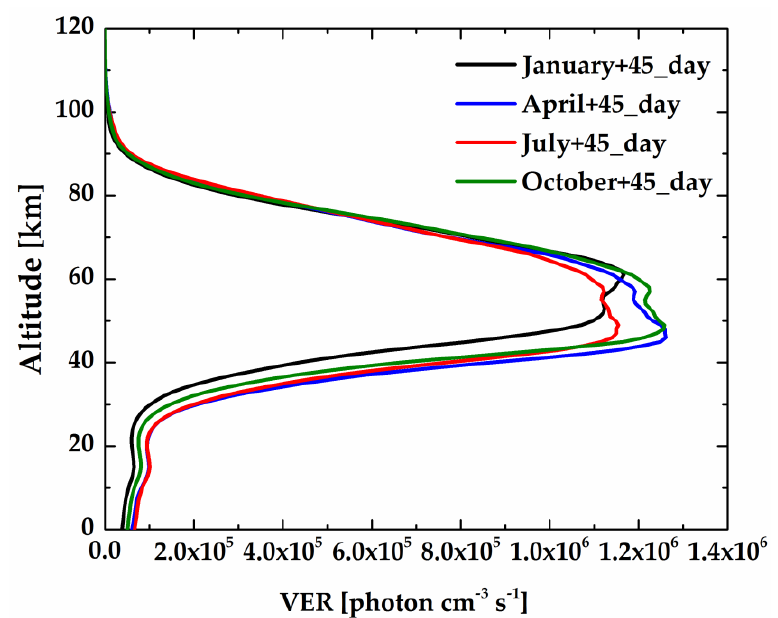
Figure 5. The calculated volume emission rate (VER) profiles of the O 2 (a 1 ∆ g ) dayglow in the four seasons.